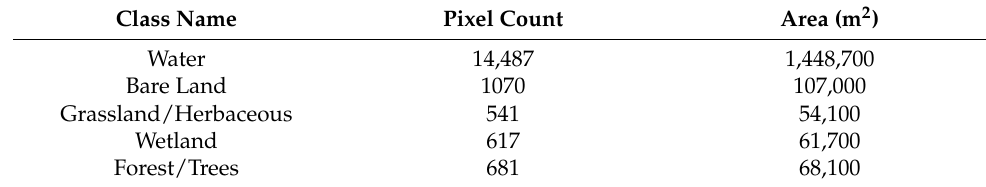
Figure 3. Pre-storm (8 September 2018) Sentinel-2 Satellite imagery of Masonboro Island ( left) and the resulting land cover classification ( right ) with corresponding Manning’s n coefficients (in parenthesis along color bar). Table 2. Pixel counts in each training sample class.